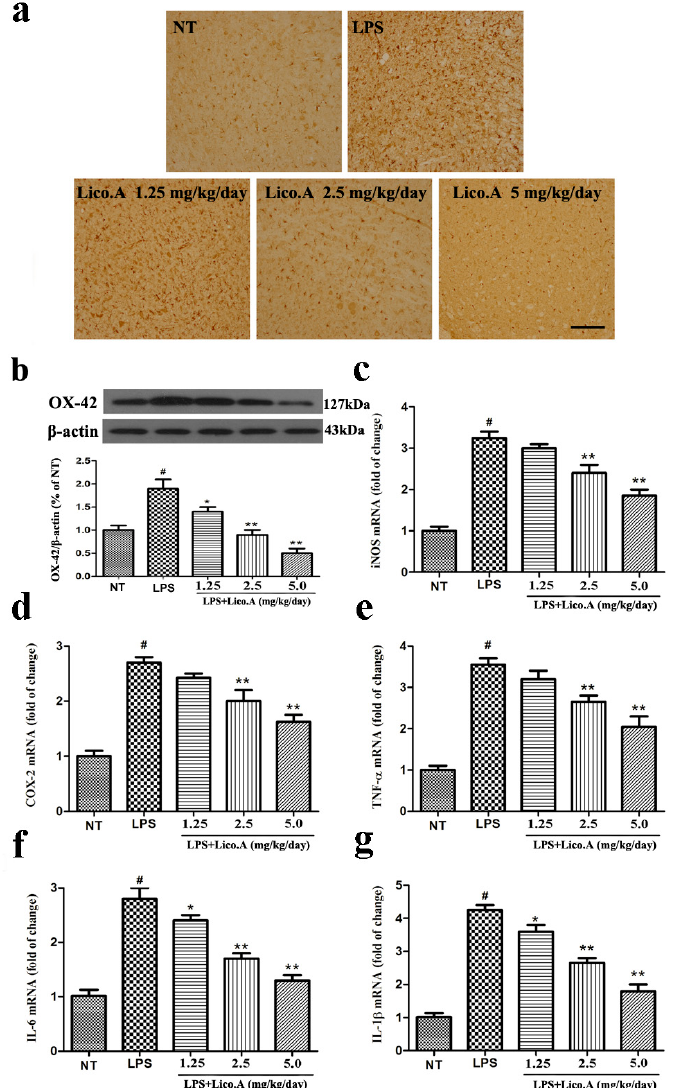
Figure 7. Lico.A treatment inhibits microglial activation and down-regulates mRNA expression of neuronal toxic factors in the SN of LPS-induced PD model rats. ( a ) The morphological changes of the microglia in the SN were shown via Iba-1 immunohistochemical staining ( n = 6 per group). Representative photomicrographs of the SN area are shown. Scale bar, 100 µm; ( b ) The expression of OX-42 was assayed by Western blot ( n = 6 per group). A representative immunoblot is shown; ( c – g ) The expression of iNOS, COX-2, TNF- α , IL-6 and IL-1 β mRNA in the SN of LPS induced PD model rats was analyzed by Real-time RT-PCR ( n = 6 per group). All the experiments were repeated at least three times and similar results were observed. Values are mean ± SE. # p < 0.01, vs. NT group and * p < 0.05, ** p < 0.01 vs. LPS group.